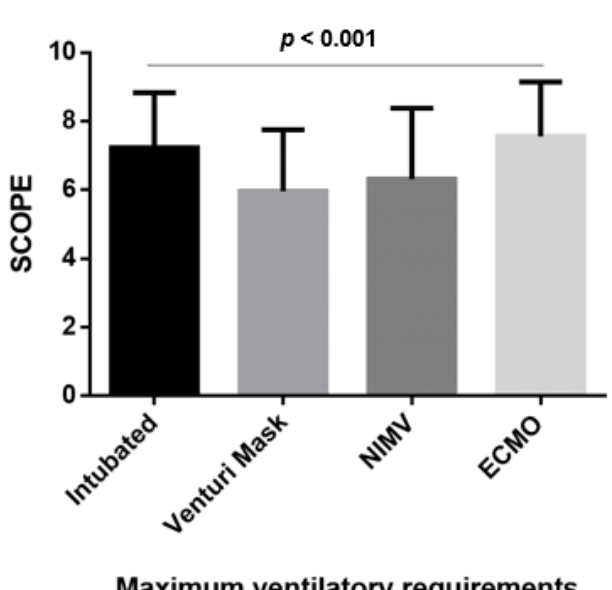
Figure 2. SCOPE according to respiratory requirements in the study subjects.